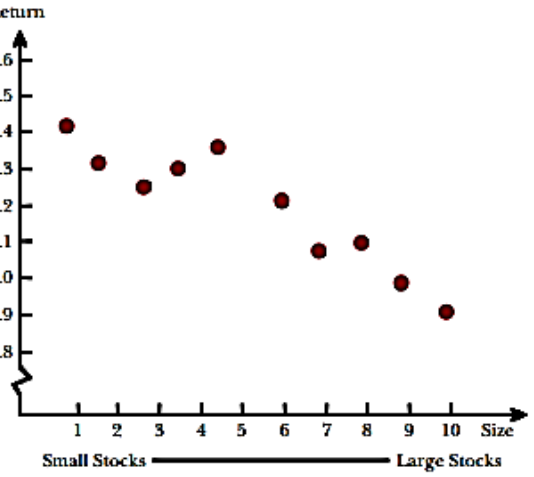
Figure 2. Portfolio for Average Monthly Returns based on Size: 1963 – 1990.